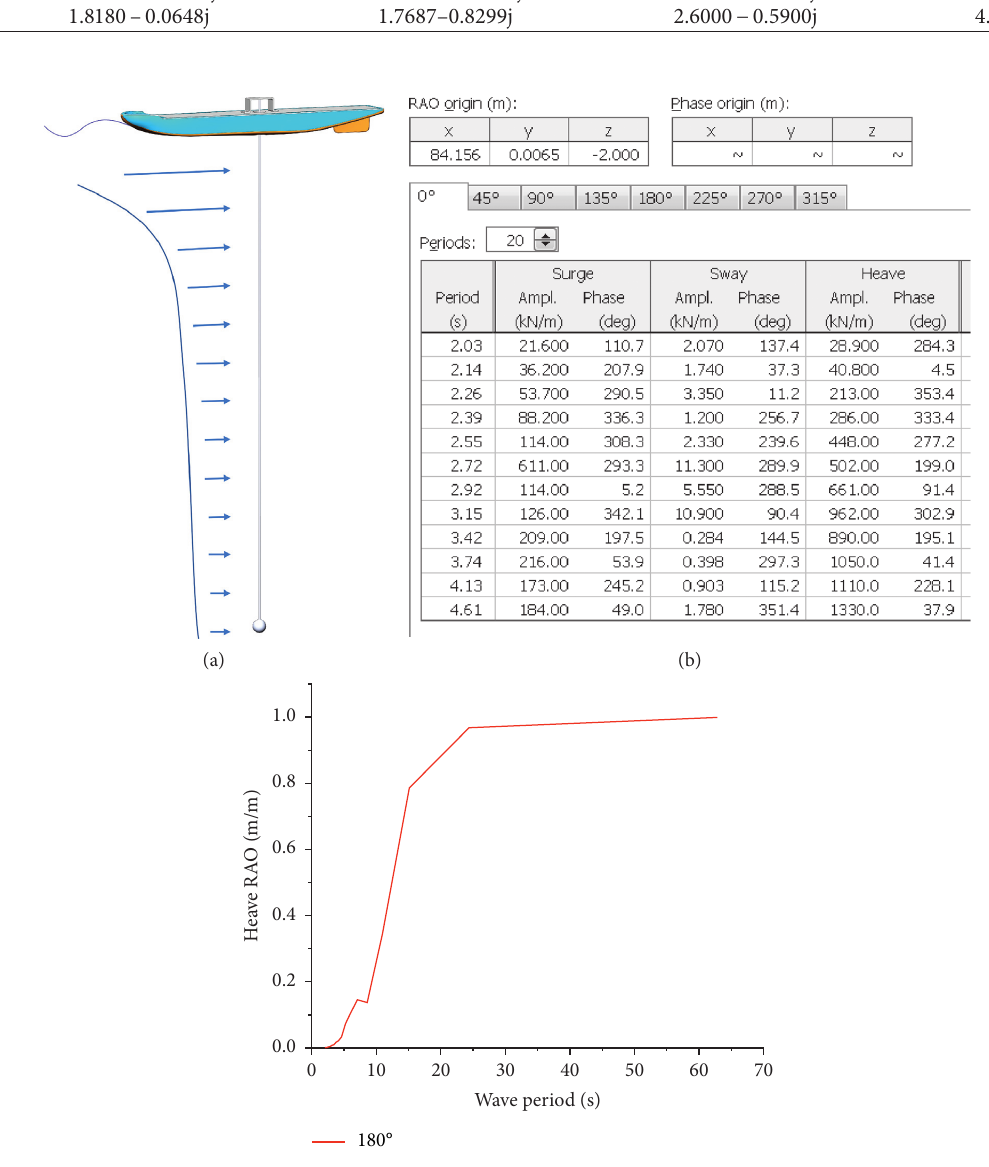
Figure 4: Simulation model based on Orcaflex: (a) solid edge model, (b) ocean current parameter setting, and (c) heave motion RAO